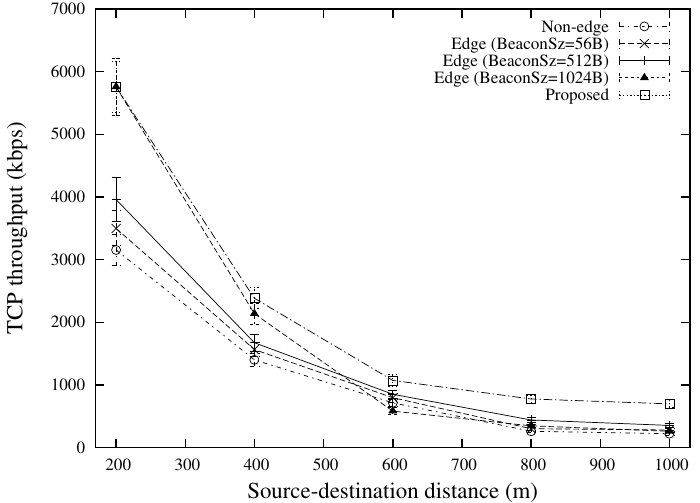
Figure 11. TCP throughput for various source-destination distances (the case of 20 TCP flows).